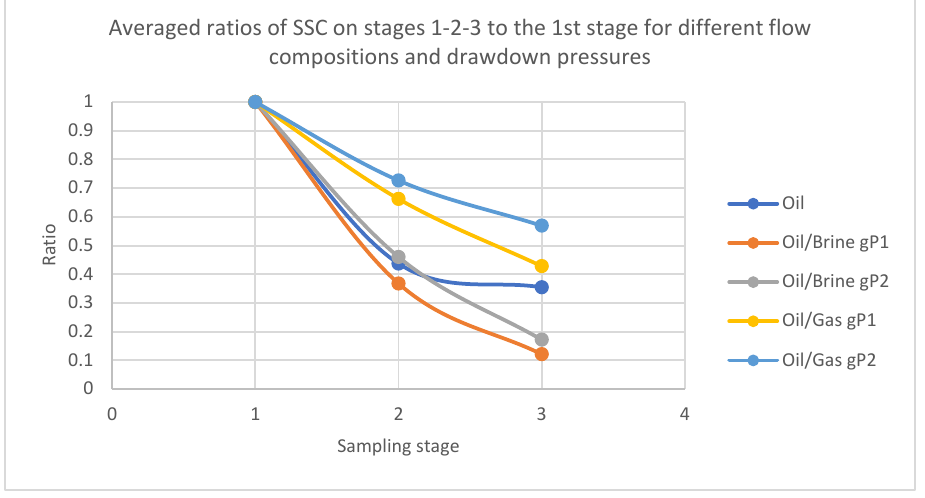
Figure 8. Combined graph for phase distribution and drawdown pressure effect on stabilization rate (d) for PSD A.